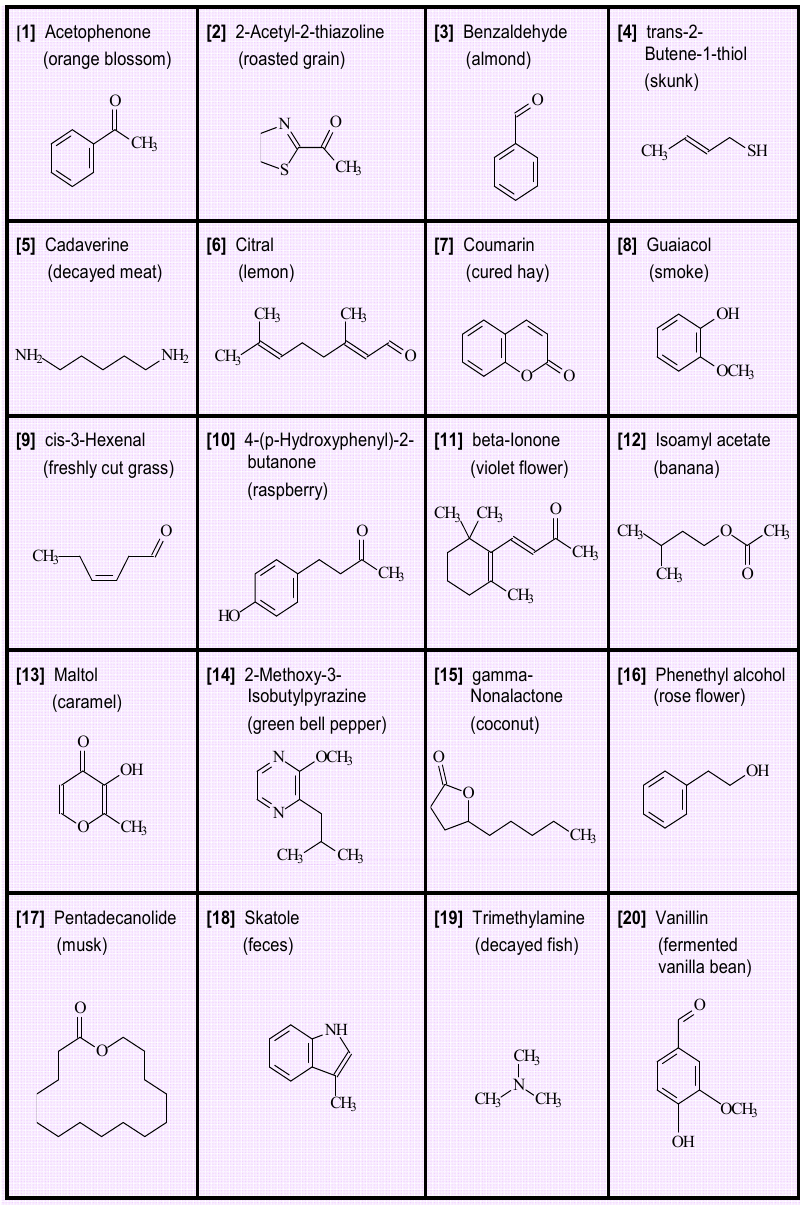
Figure 1. Structures of odor objects captured by one compound. The 20 chemicals occur in nature and have different, distinct odors that represent a wide range of chemical structure and odor variety. In contrast to color vision (based on three pigments with sensitivities peaking at blue, green, or red regions of visible electromagnetic spectra), there are tens of taste receptors and hundreds of odor receptors tuned to water-soluble and vaporous chemicals, respectively. The 20 times as many olfactory-neuron than taste-cell receptor variants match numerical differences in distinct odors and tastes perceived. From [1] with permission from Wiley.